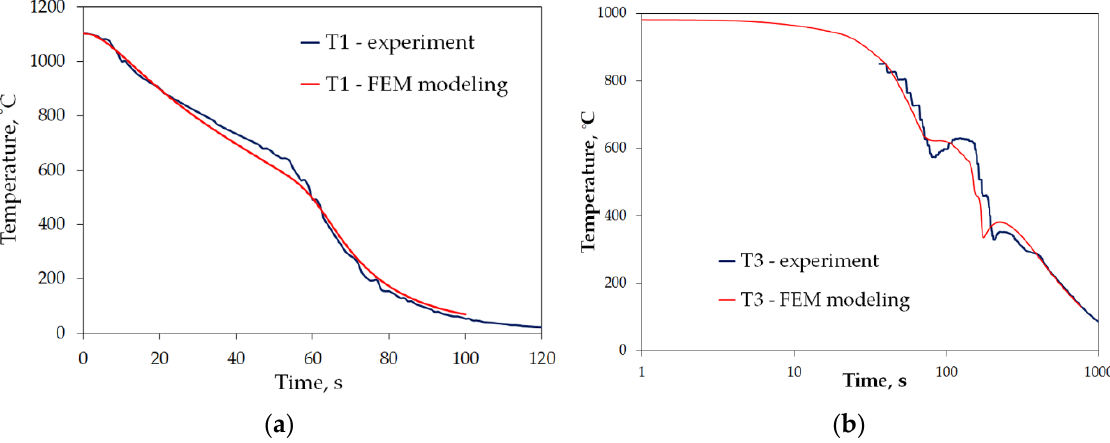
Figure 11. Validation of obtained heat transfer coefficients in cooling test: ( a ) small sample of mar- tensitic stainless steel (Figure 1a), and ( b ) big sample—a complex-geometry forged part (Figure 1b).